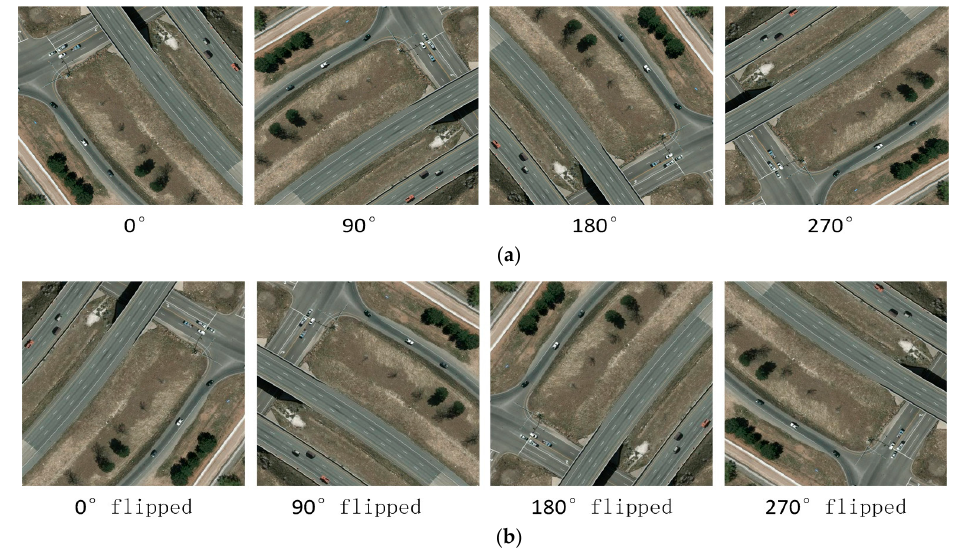
Figure 2. ( a ) Training images are rotated with four angles in clockwise; ( b ) The flip operation of the training images.